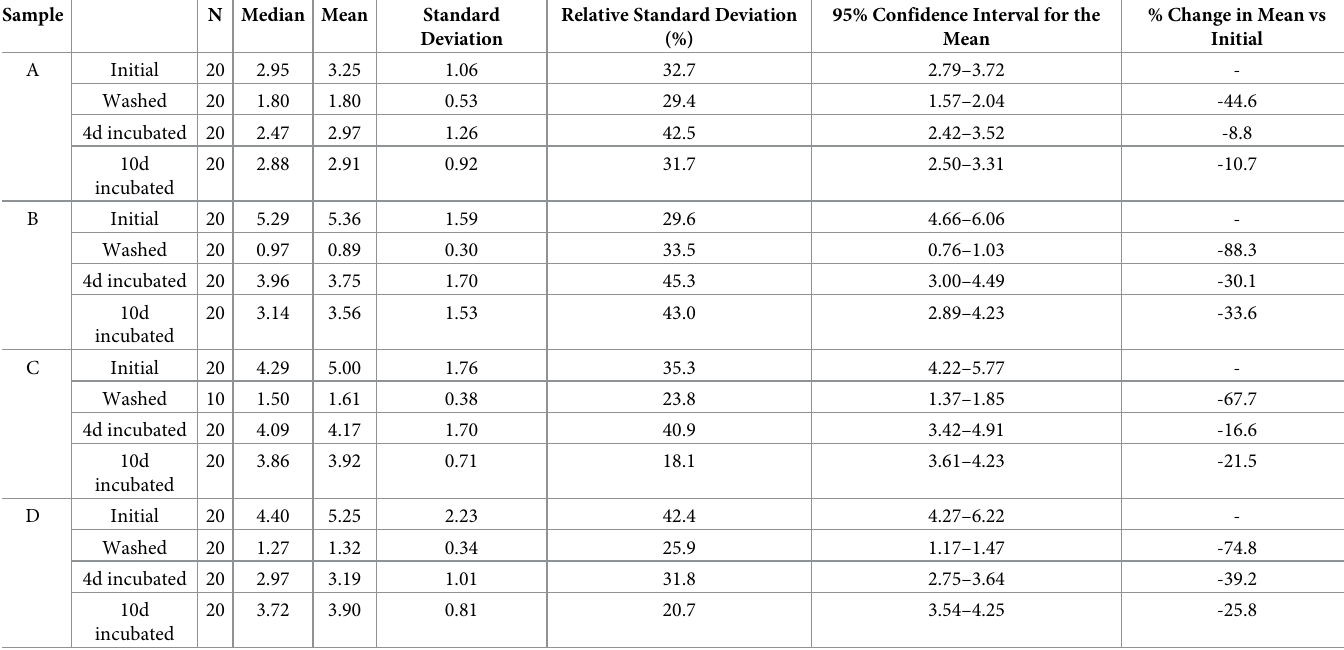
Table 2. Statistical summary of 35 Cl - /C 4 H 3- intensity ratios for four samples washed and incubated at